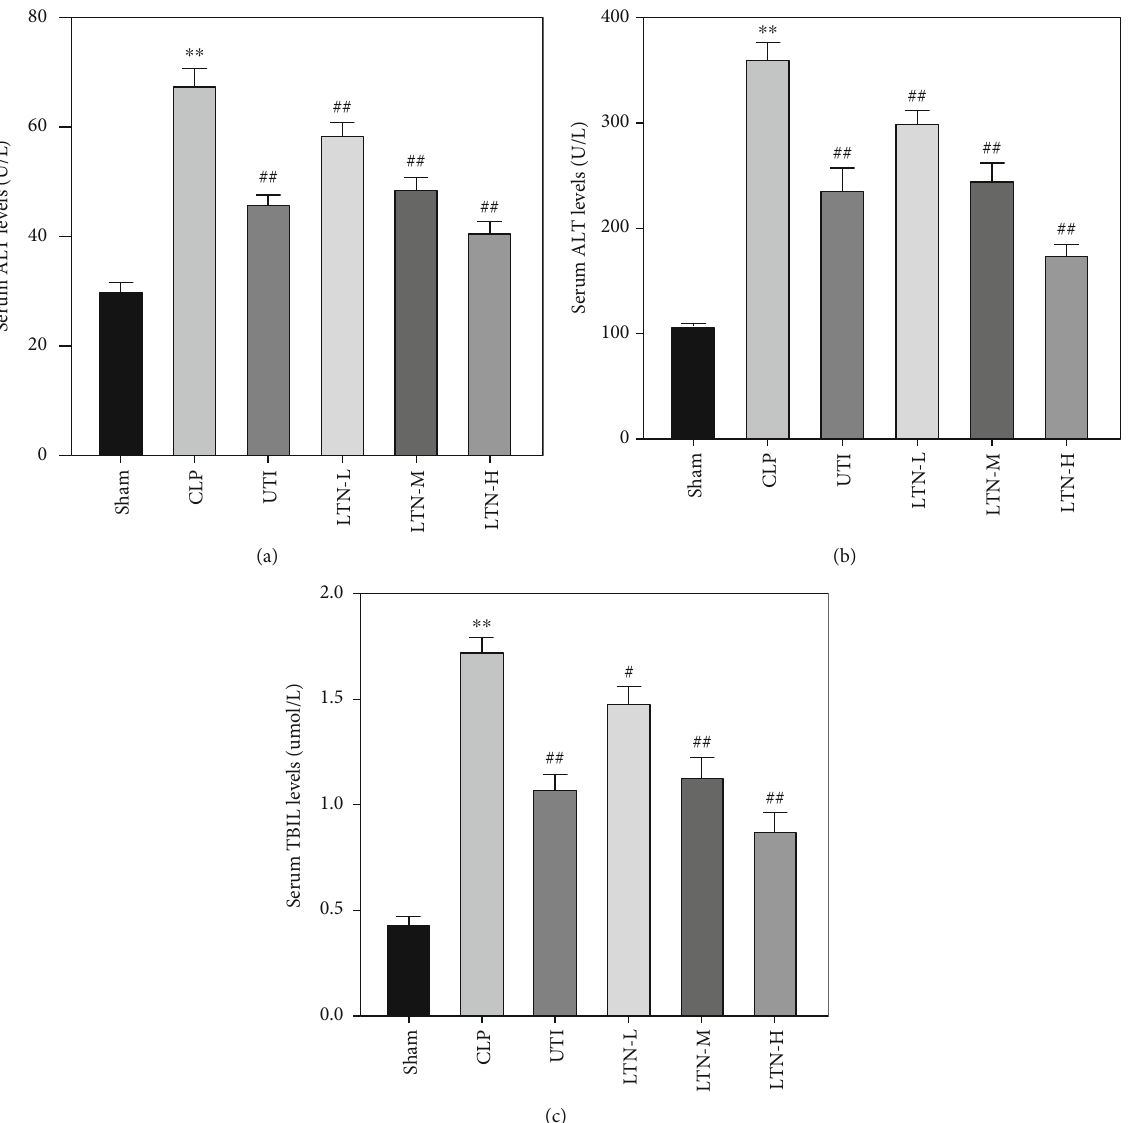
Figure 3: E ff ect of lentinan on serum ALT (a), AST (b), and TBIL (c) levels in mice with gut-origin sepsis. ALT: alanine aminotransferase; AST: aspartate aminotransferase. The experimental results were expressed in the form of the mean ± standard deviation (SD). ∗∗ p < 0 : 01 vs. sham group. # p < 0 : 05 and ## p < 0 : 01 vs. CLP